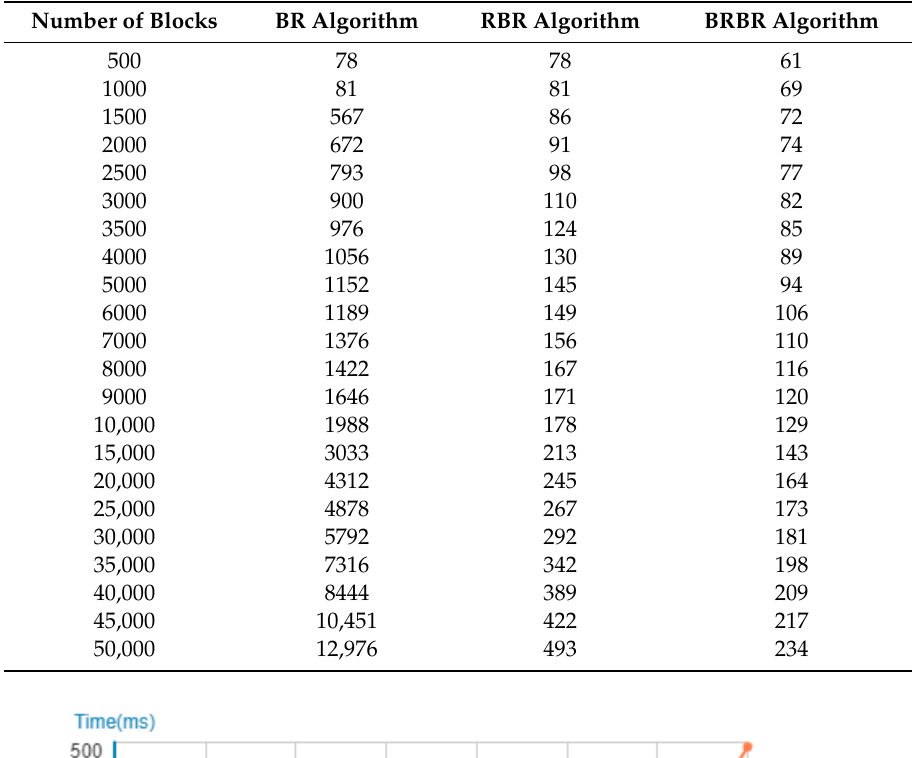
Table 3. Time comparison table of three retrieval algorithms under di ff erent block file sizes (unit: ms).